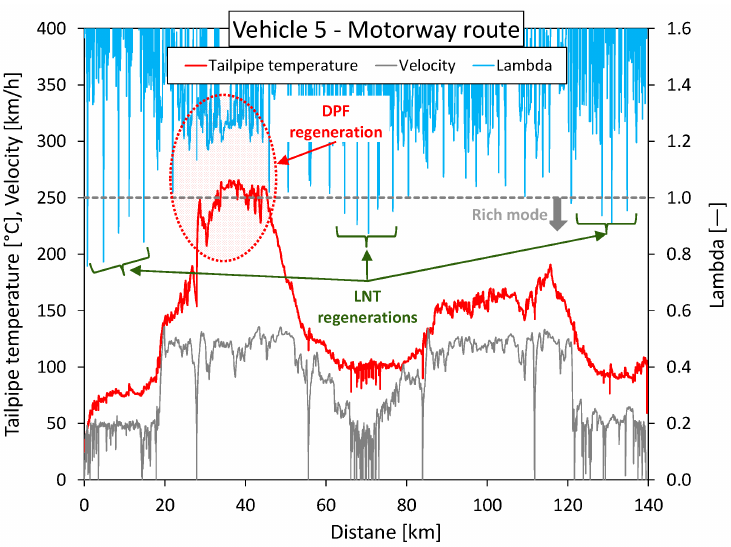
Figure 6. Tailpipe and lambda profiles during the motorway route with DPF regeneration.